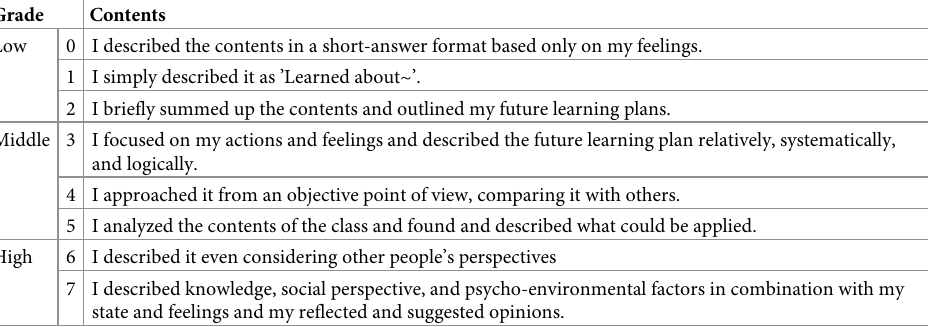
Table 1. Reflective thinking level in